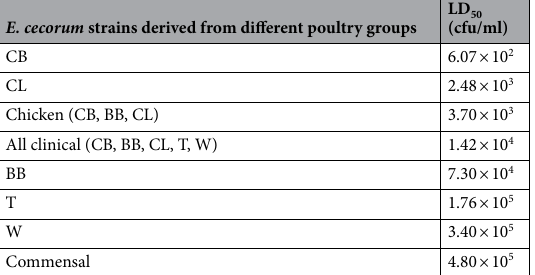
Table 3. The LD 50 of clinical (CB, CL, BB, T, W) and commensal Enterococcus cecorum strains for SPF chicken embryos.